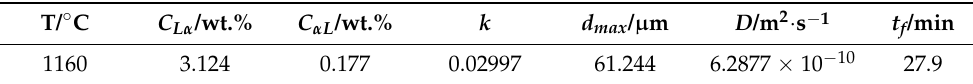
Table 5. The result of the data required for